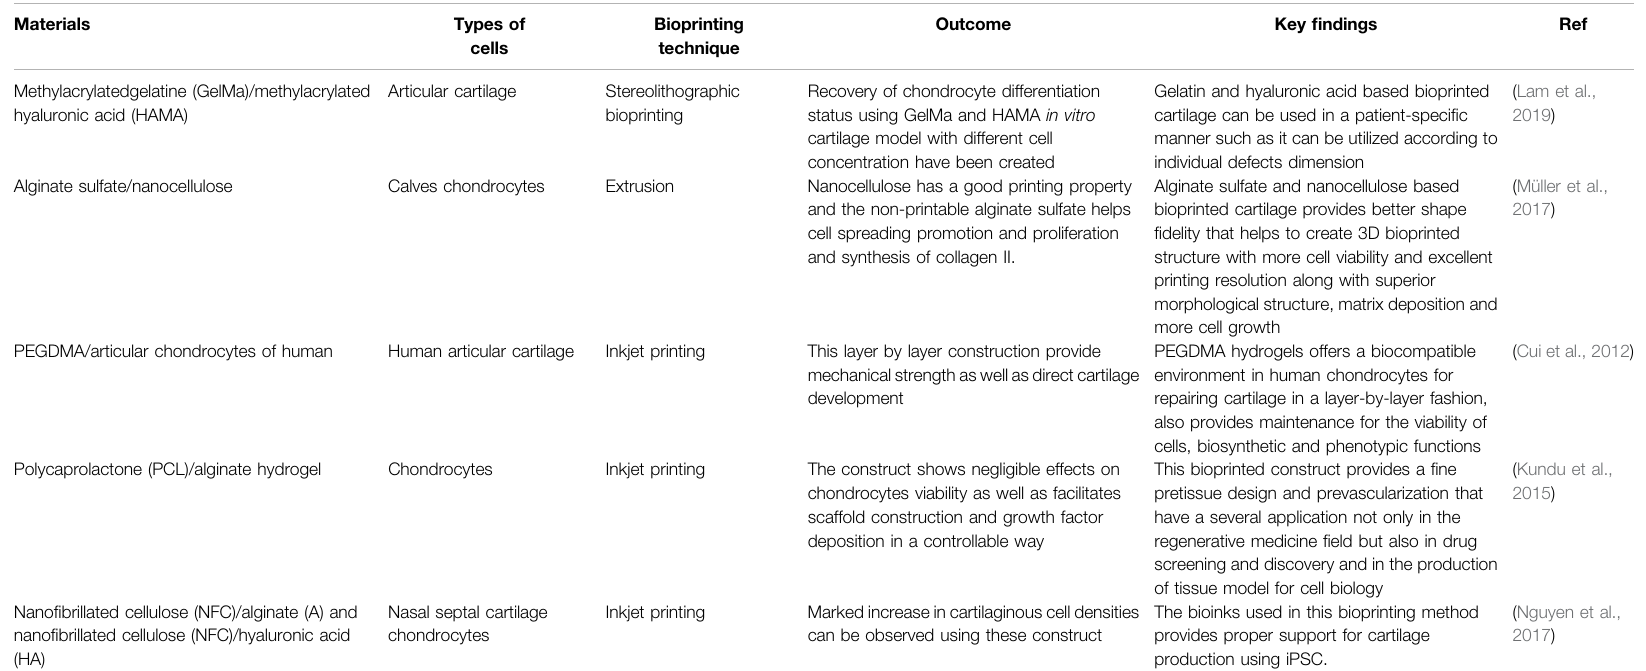
TABLE 4 | Comparative summary of different 3D bioprinting techniques used in cartilage tissue